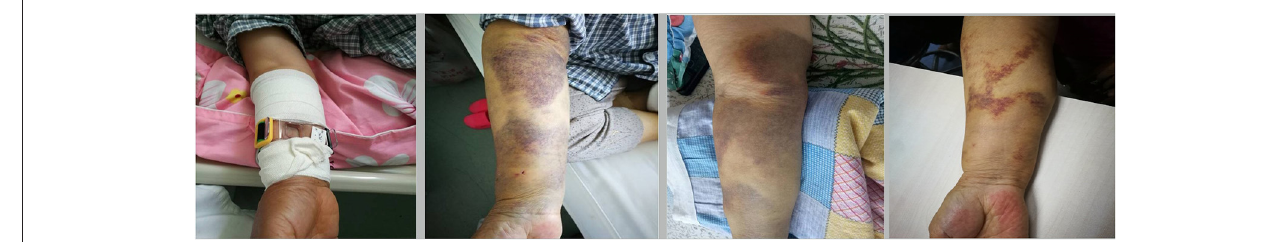
FIGURE 4 | Continuous observation of moderate hematoma.